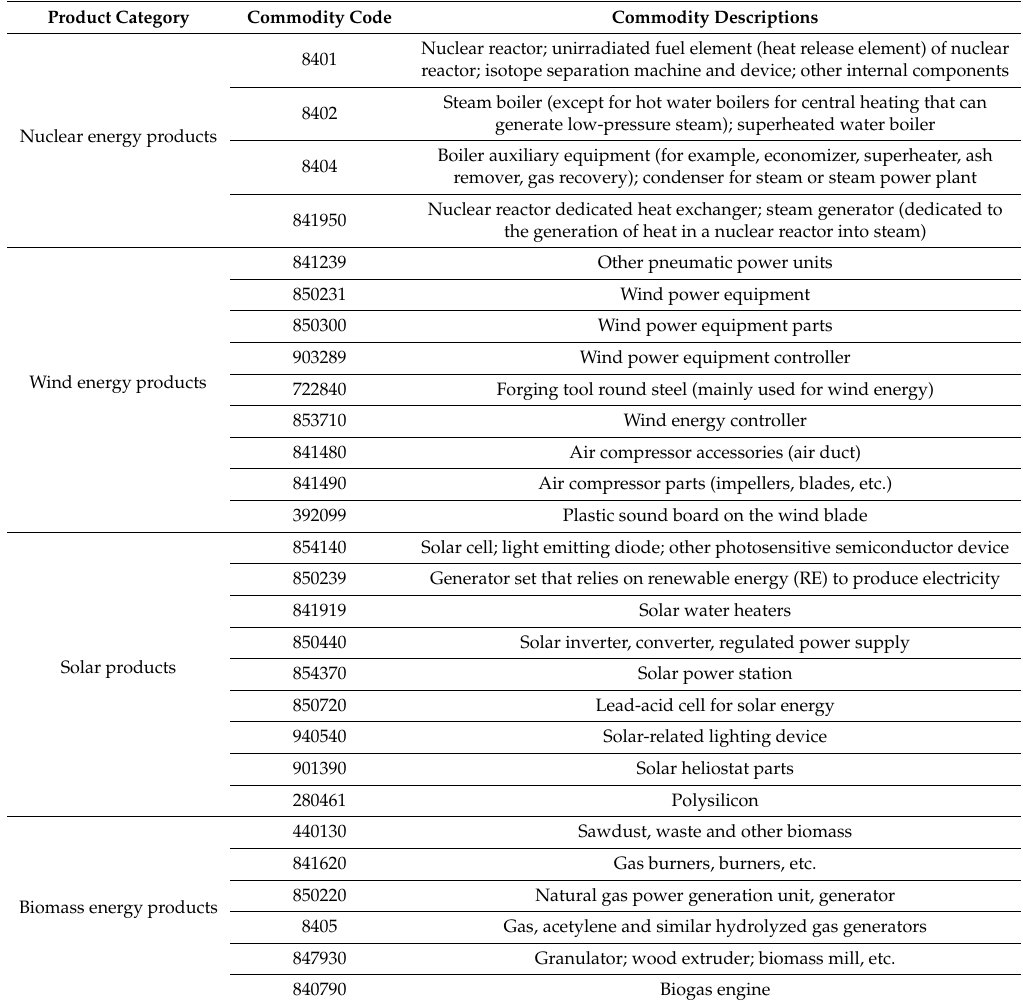
Table 1. The categories of renewable energy products (REPs) and their Harmonized Commodity Description and Coding System (HS)